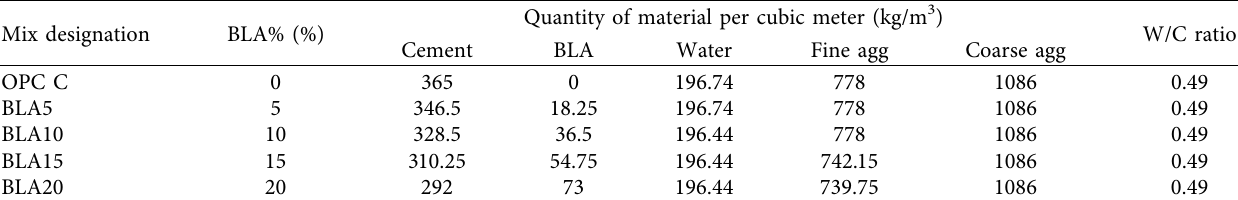
Table 7: Mix proportion summery.